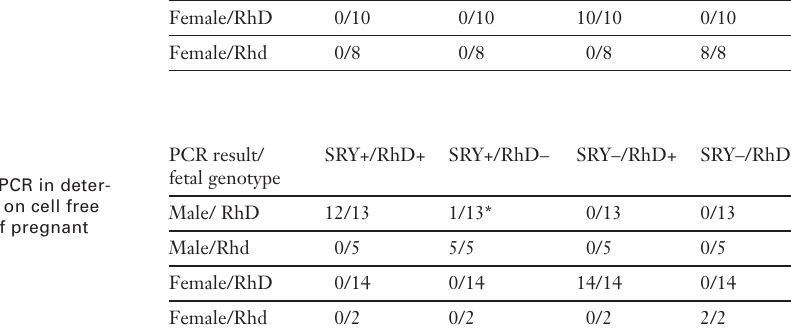
Accuracy of real-time multiplex PCR in deter- mining sex and Rhesus D status on cell free DNA isolated from the plasma of healthy blood donors.